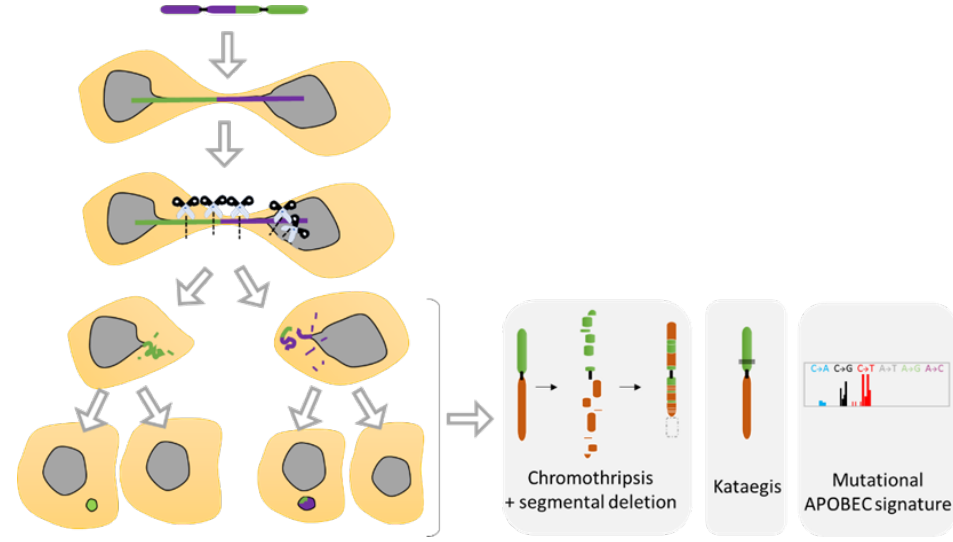
Figure 8. Chromosomal instability resulting from nuclear envelope disruption (NED) during telomere fusion. Dicentric chromosome under mitosis ends up in two daughter cells connected by a chromatin bridge. Studies have shown that the dicentric chromosome will break in response to NED and the attack of TREX1 proteins as well as due to extensive mechanical forces from the cytoskeleton. The resulting breaks will generate diverse structural variants as the formation of chromothripsis, kataegis as well as a located mutagenesis APOBEC signature. Furthermore, defective replication on the broken bridge of the chromosome scales up the genomic instability suffered by the cells that will progress in the formation of micronuclei in the next mitosis, increasing considerably the genomic instability (Adapted from Umbreit et al. [110] and Maciejowski et al. [70]).